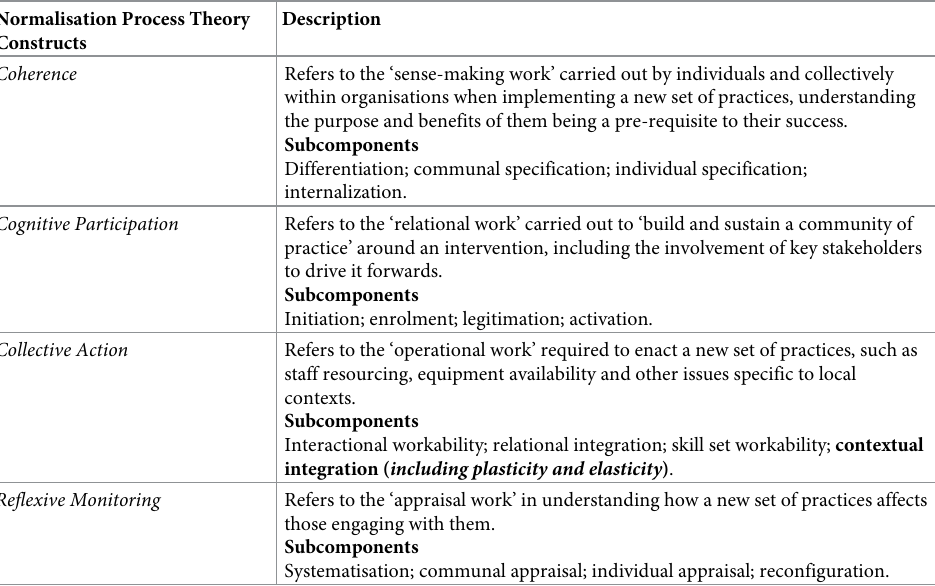
Table 1. Normalisation process theory constructs & description